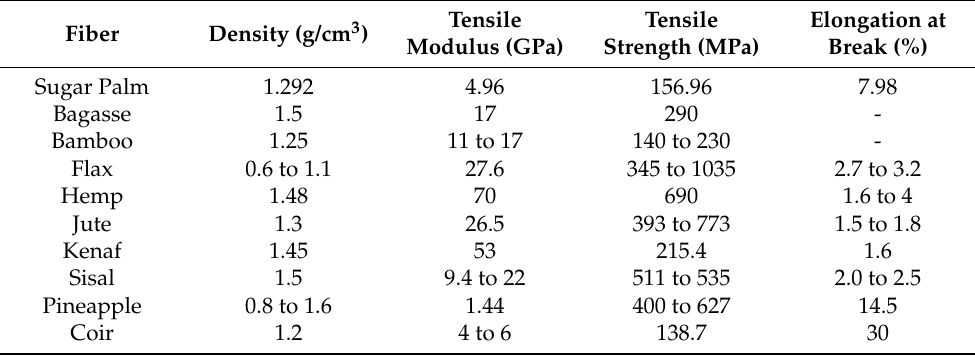
Table 2. Comparison of the mechanical performance of SPF with other lignocellulosic fibres. The data are adapted from Ref. [37]. Creative Common CC BY license.